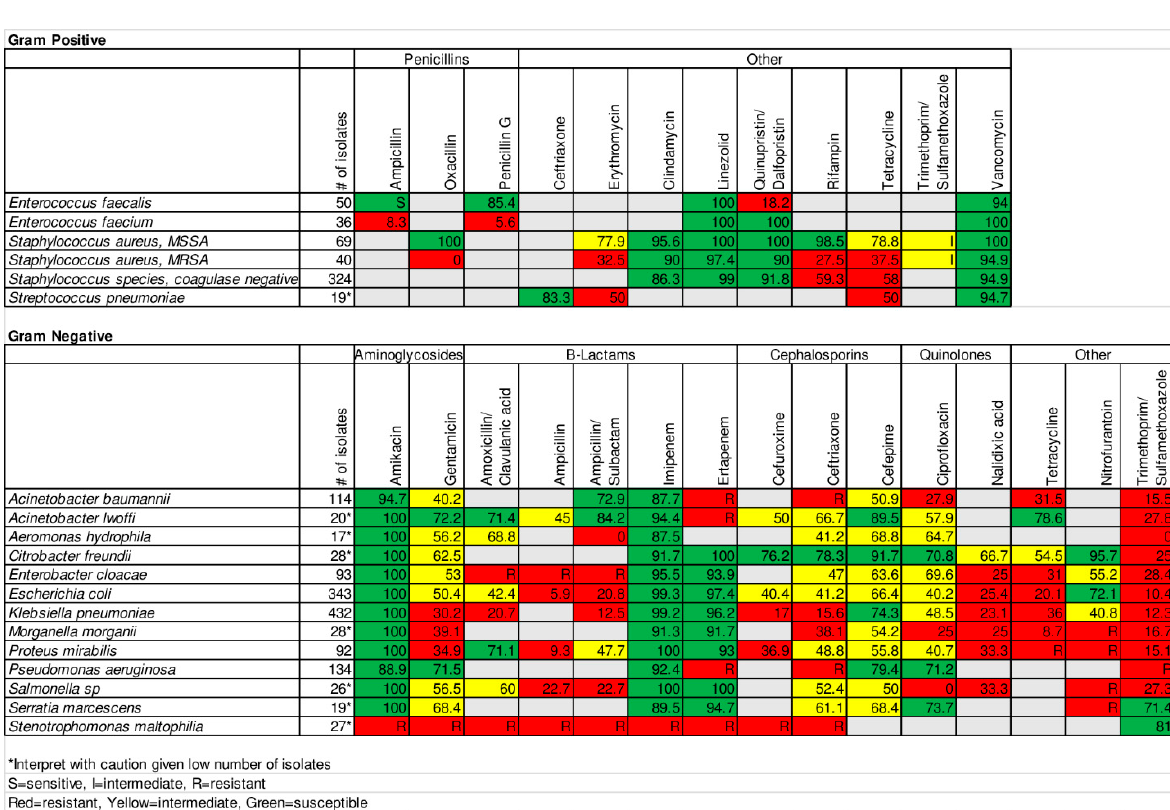
Figure 1. UTH antibiogram for infectious disease specialists.